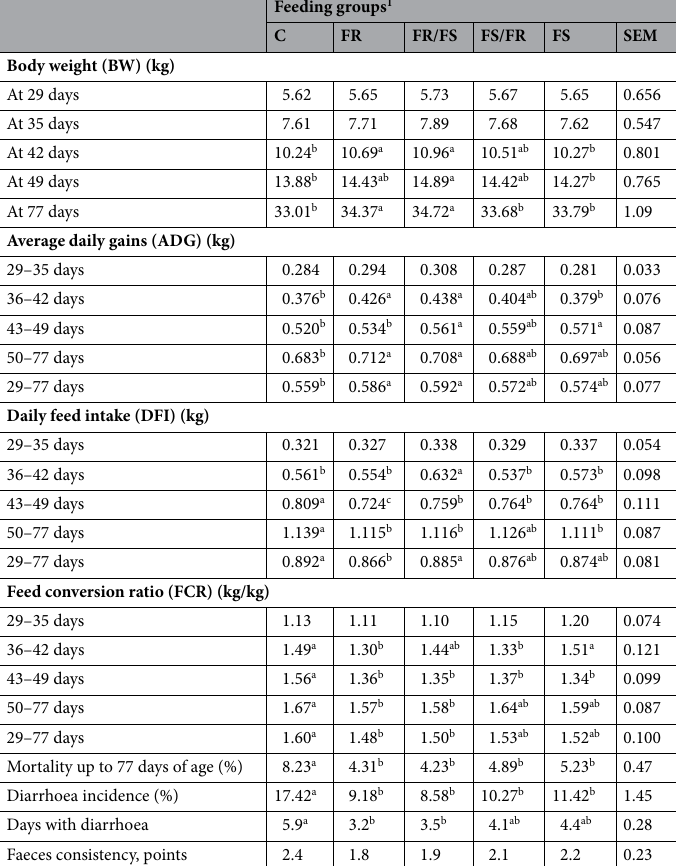
Results of the microbiological and histological analysis of the gastrointestinal tract. The ani- mals from the FR/FS group had a significantly higher total bacterial count in the contents of the ileum. The bacterial count in the faeces was significantly higher in the control group than in the other groups (Table 4). The total fungal count in the ileum contents was significantly higher in the control group animals vs. ani- mals from the FS and FR groups, between which there was also a statistically significant difference (FS > FR). In the faeces of the piglets from the control group, the number of fungi was significantly higher than in the other groups (Table 4). The inclusion of the fermented component in the feed for the piglets affected the total number of coliforms and Escherichia coli bacteria. The total number of these bacteria in the ileum was significantly higher in the con- trol group and, in the case of coliforms, also in the group with 8% FSBM supplementation (group FS), compared to the other groups (Table 4). The number of coliforms and E. coli in the faeces, as in the ileum, was significantly higher in the control animals than in the piglets receiving diets with fermented components (C vs. FR, FR/FS, FS/FR, and FS). The lowest numbers of both coliforms and E. coli were recorded in group FS (FS < FS/FR < FR = FR/FS). Significant differences were also noted in the number of anaerobic bacteria Clostridium perfringens in the faeces, which was significantly higher in group C than in the other groups, with significant differences between them: FR/FS < FS/ FR < FR = FS (Table 4). The fermented component used in the feed in the amounts of 6% FRSM and 2% FSBM increased the length and width of the villi in the ileum, compared to the other groups (Table 5). The shortest villi were noted in groups C and FS/FR, and the narrowest villi were observed in group C. The deepest crypts in the ileum were found in groups C and FR vs. groups FR/FS and FS/FR. The group C animals had the widest crypts, compared to the other groups, between which there were statistically significant differences, i.e. FR = FR/FS < FS/FR = FS. It should also be noted that the width of the mucosa was significantly greater in the FR/FS group than in group C (Table 5). The inclusion of FRSM in the feed significantly reduced the depth and width of the crypts in the caecum and colon compared to the control group. A reverse relationship was observed for the width of the caecum mucosa